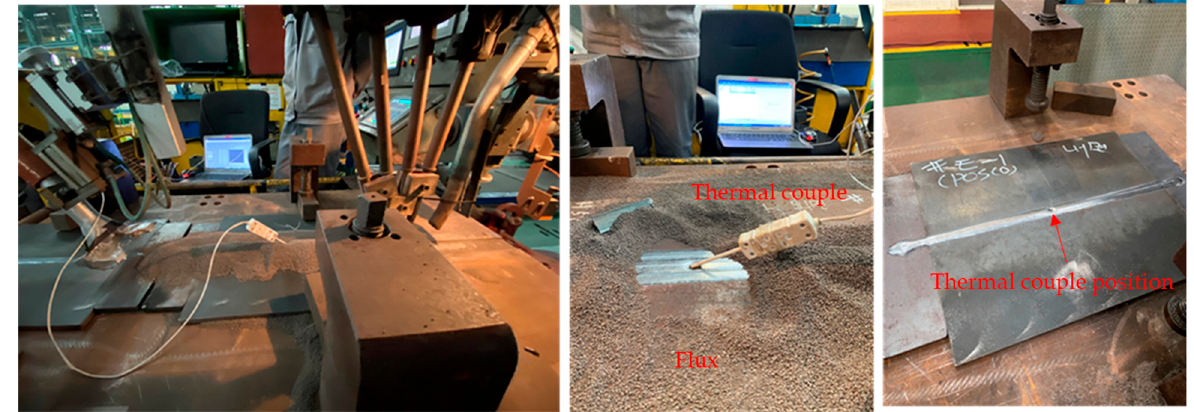
Figure 3. Thermocouple location for measuring thermal cycle during welding process.